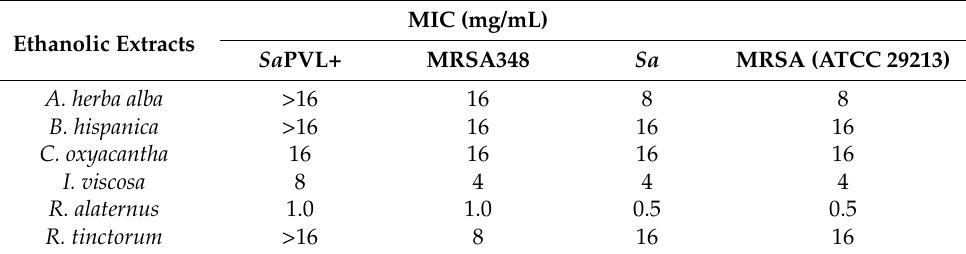
Table 2. Minimum inhibitory concentrations of ethanolic extracts of the six plants selected using the qualitative test against S. aureus